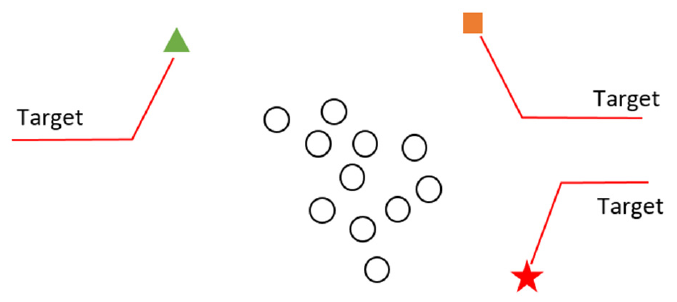
Figure 14. Communication status of swarms with different missions in the same area.